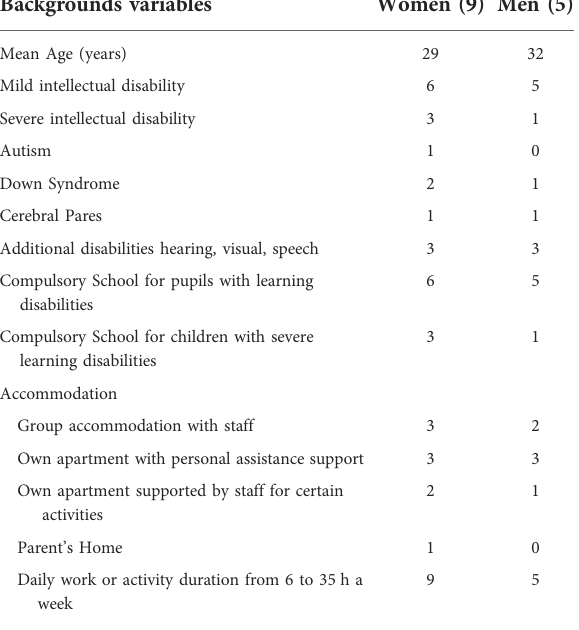
TABLE 2 Participants involved for the entire 3 years training and their background variables. Backgrounds